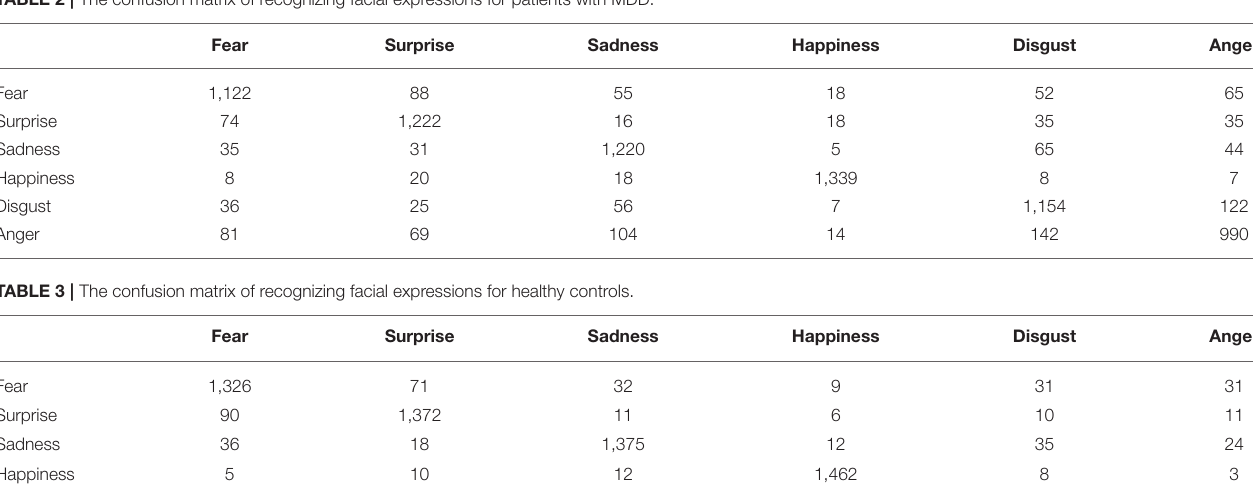
TABLE 2 | The confusion matrix of recognizing facial expressions for patients with MDD.